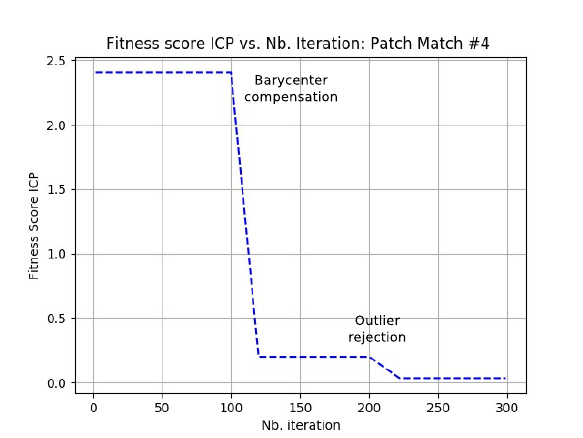
Figure 5. The output of the patch-based pose estimation procedure generated for the Fabas dataset: iterative pose estimation process obtained for the patch match (cid:93) 4 , n G = 54592 3D points (representing the ground), n in = 33668